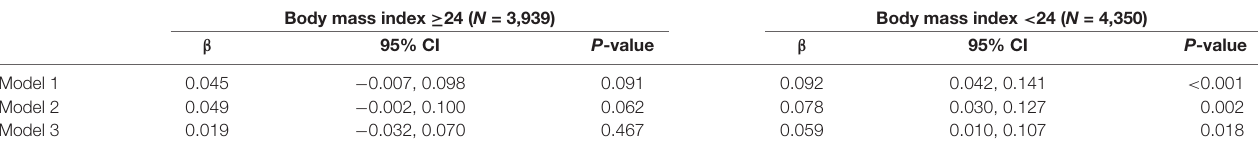
TABLE 2 | Association of childhood neighborhood quality and cognitive function in adults by body mass